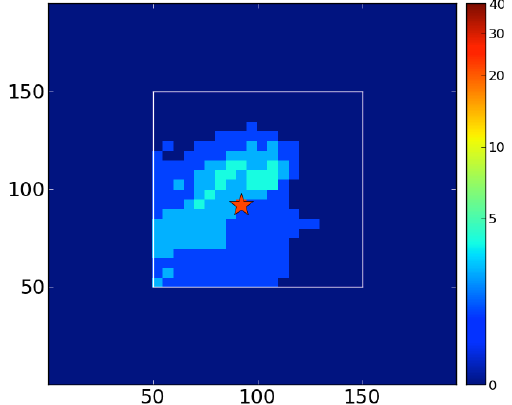
Figure 5. Reduction in uncertainty of 6-day averaged fluxes for the Figure 4. Reduction in uncertainty of 6-day averaged fluxes for the ) ) for CH 4 fluxes. The time 00:00–06:00UTC (100 × ( 1 − σ POST ) ) for CO 2 fluxes in the time 00:00–06:00UTC (100 × ( 1 − σ POST σ PRIOR σ PRIOR 200km × 200km domain is centered at the location of Shanghai case with only CO 2 measurements. The red star shows the location (31.2 ◦ N, 131.5 ◦ of the power plant. The 200km × 200km domain is centered at the location of Shanghai (31.2 ◦ N, 131.5 ◦ E).